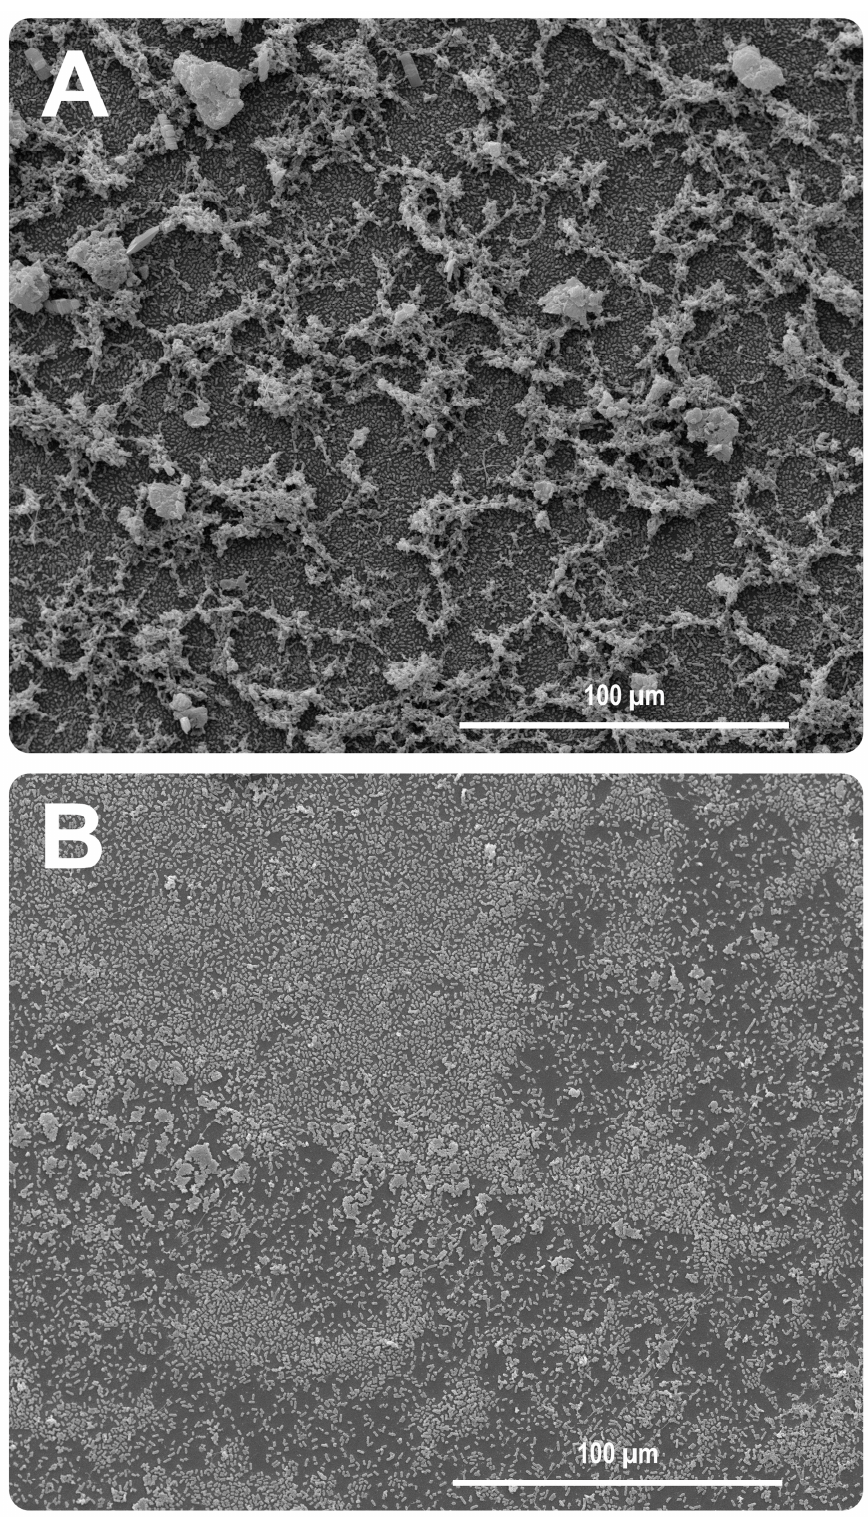
Figure 5. Scanning electron micrographs of low magnification (1000 × ) of enteroaggregative Figure 5 . Scanning electron micrographs of low magni fi cation (1000×) of enteroaggregative Esche- Escherichia coli (EAEC 042) and KPC-producing K. pneumoniae biofilms at an early stage of richia coli (EAEC 042) and KPC-producing K. pneumoniae bio fi lms at an early stage of formation. Both bio fi lms were grown on a glass surface for 24 h. ( A ) EAEC bio fi lm shows the initial development of three-dimensional architecture, with cellular aggregates and a remarkable amount of EPS. ( B ) KPC bio fi lm in the initial stage of development, without cell aggregates, no exopolysaccharide matrix, and absence of three-dimensional structure.